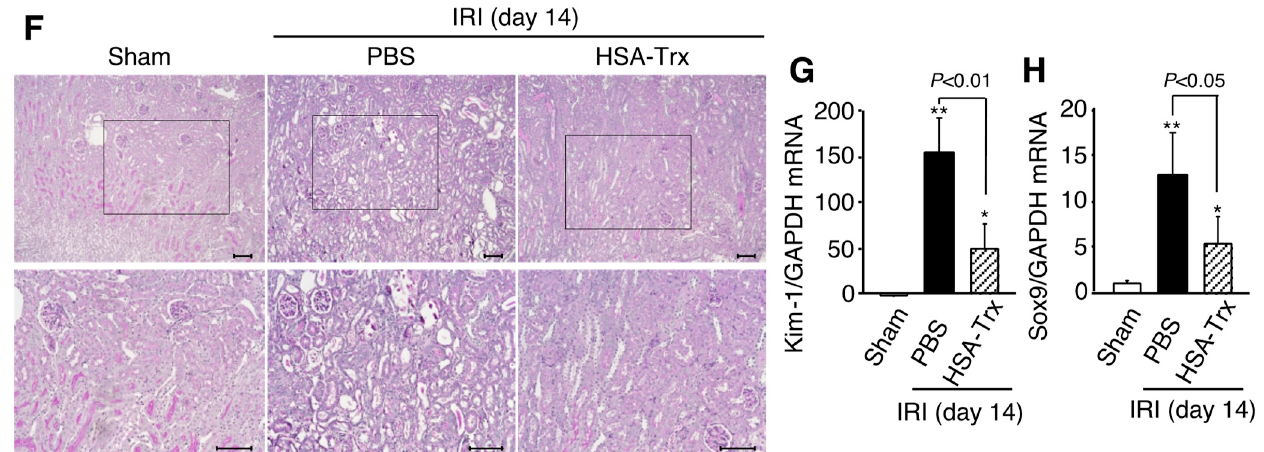
Figure 1. Renoprotective effect of HSA-Trx against AKI to CKD transition. ( A ) Experimental protocol for the effective evaluation of HSA-Trx on renal IR-induced AKI to CKD transition model mice: The mouse model of AKI to CKD transition was induced by renal IR where both renal pedicles were clamped for 35 min. HSA-Trx (400 nmol/kg) was administered intravenously on 1, 3 and 5 days after renal IR. An equivalent amount of PBS (10 mL/kg) was administered to the sham operation group and the renal-IR group. The mice were sacrificed 14 days after IR. ( B ) Blood urea nitrogen (BUN), ( C ) serum creatinine (SCr) and ( D ) creatinine clearance (Ccr) were measured at 1, 7 and 14 days after renal IR. ( E ) Percent change in body weight from the baseline (before renal IR). Data are expressed as the mean ±SD ( n = 5). * p < 0.05, ** p < 0.01 compared with sham mice at each time point. # p < 0.05, ## p < 0.01 compared with renal IR-mice administered with PBS at each time point. Effect of HSA-Trx against renal tubular damage in renal IR-treated mice 14 days after IR: ( F ) Representative photomicrographs of Periodic Acid Schiff (PAS)-stained kidney sections are shown for 14 days after renal IR. Lower panels are an enlarged image of the upper panel. Original magnifications: ×200 (upper panels); ×400 (lower panels). Scale bars represent 100 μ m. mRNA expression of ( G ) Kim-1 and (H) Sox9 in kidney on 14 days after renal IR were determined by real-time PCR. Data are expressed as means ±SD ( n = 5). * p < 0.05, ** p < 0.01 compared with sham mice.